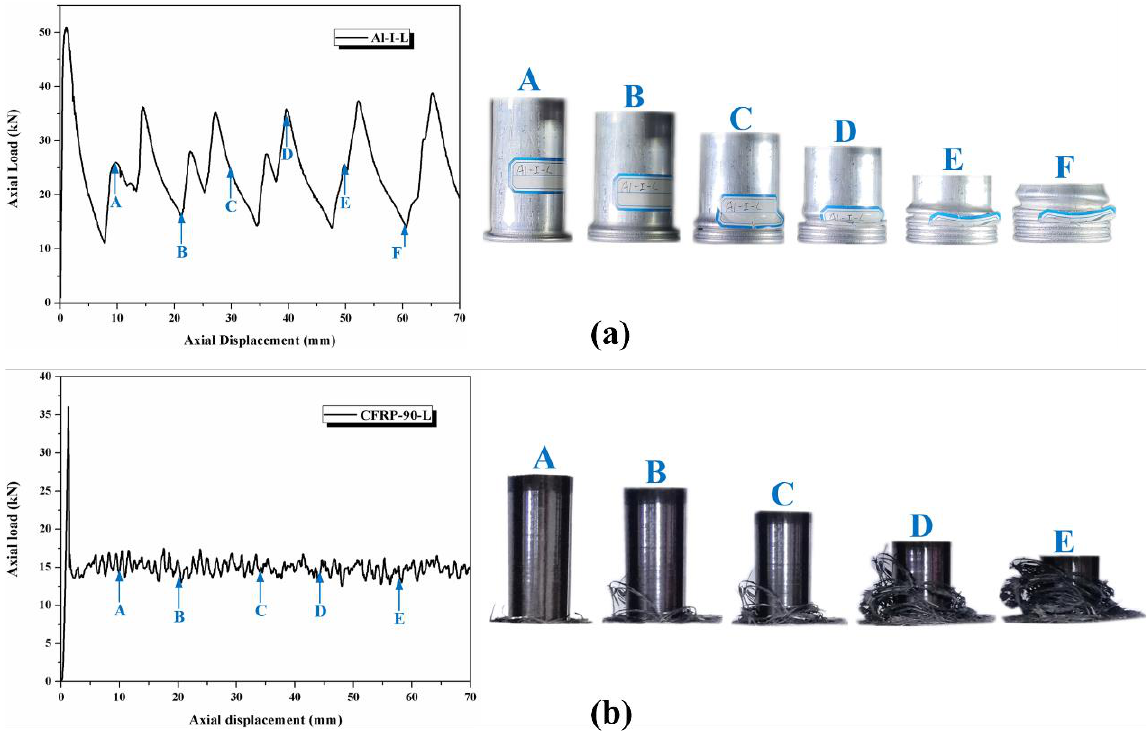
Figure 5. Load – displacement curves and crushing process of ( a ) aluminum alloy circular and ( b ) CFRP tubes. ( b ) CFRP